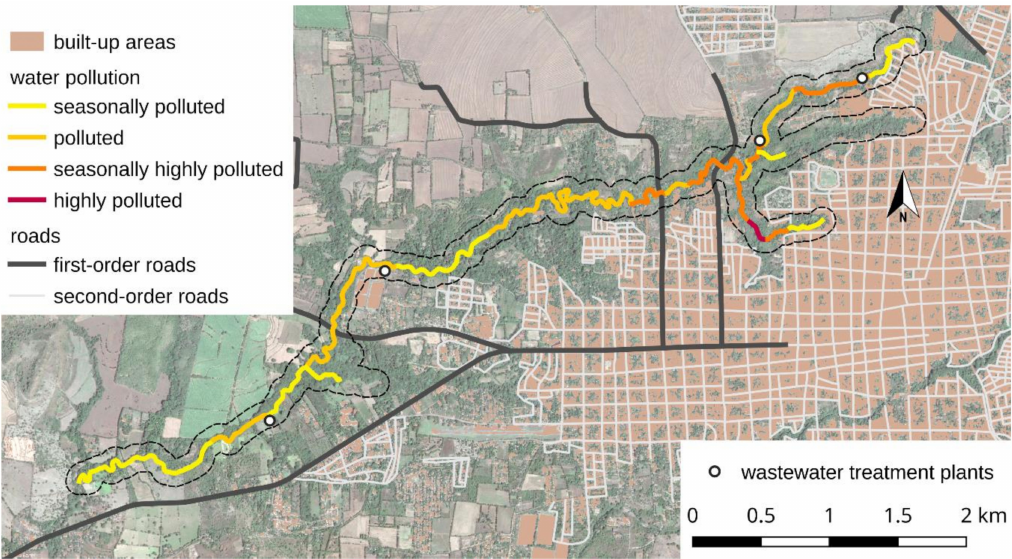
Figure 2. Map showing the three threats (built-up areas, water pollution, and roads) resulting from urbanization that were considered in this